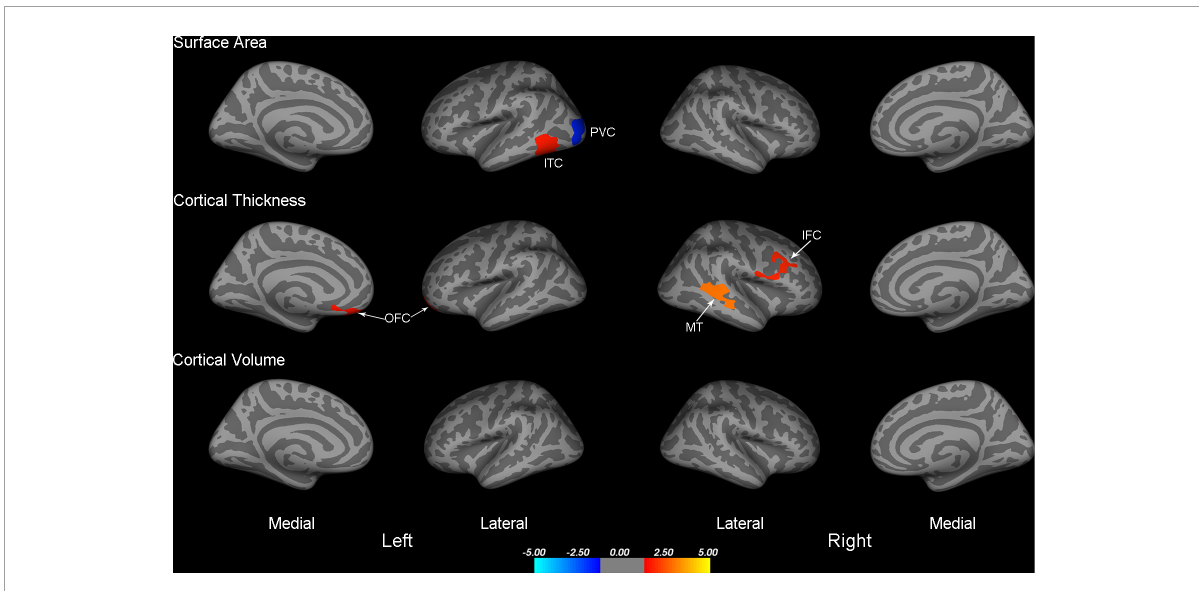
FIGURE1 Maps of surface area, cortical thickness, and cortical volume differences between IXT and HC ( P < 0.05, Monte Carlo corrected). PVC, primary visual cortex; ITC, inferior temporal cortex; OFC, orbitofrontal cortex; MT, middle temporal cortex; IFC, inferior frontal cortex; IXT, intermittent exotropia; HC, healthy